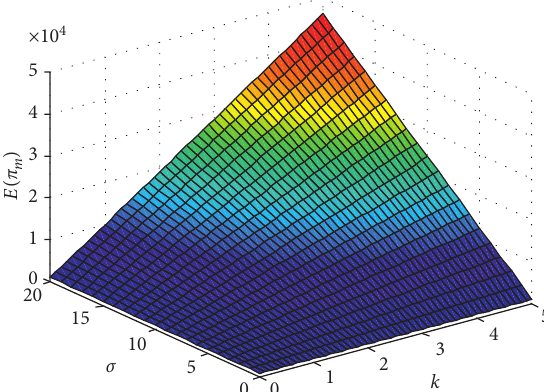
Figure 3: The trend of the manufacturer’s profits under the manufacturer-dominant